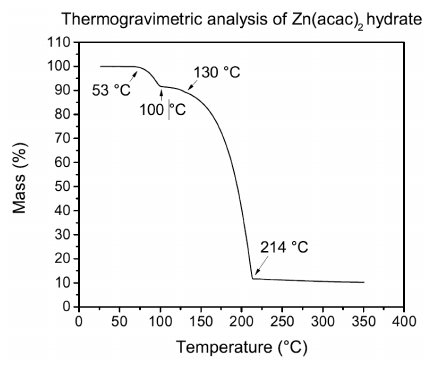
Figure 4. Zinc acetylacetonate TGA in nitrogen atmosphere at atmospheric pressure. Heating rate: 5 ◦ C/min.